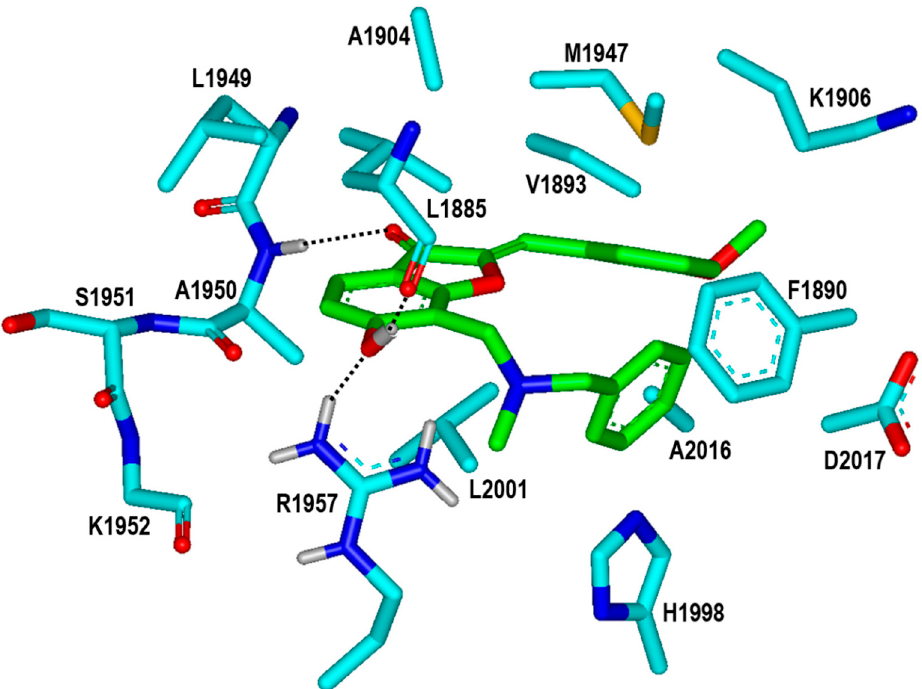
Figure 6. Calculated binding mode of Inhibitor 1 in the ATP-binding site of the G2019S mutant of LRRK2. The carbon atoms of the G2019S mutant and Inhibitor 1 are colored in cyan and green, respectively. Each dotted line indicates a hydrogen bond.